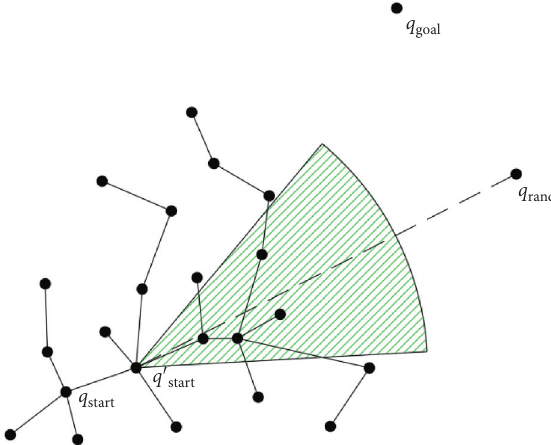
Figure 8: A search based on the steering